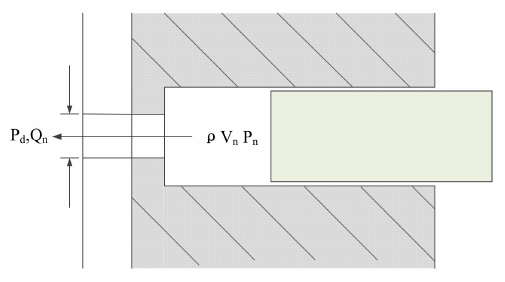
Figure 5. Schematic of single plunger oil discharge